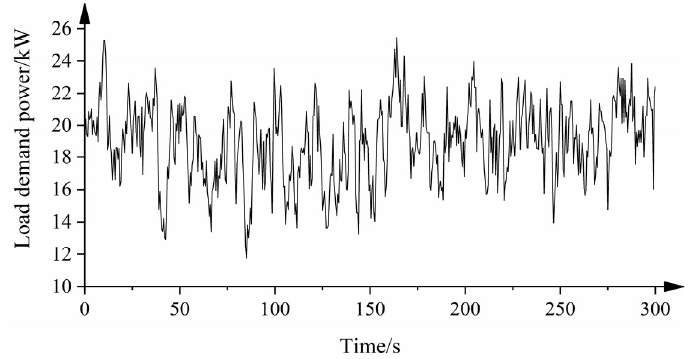
Figure 10. The load demand power of the hybrid tractor.